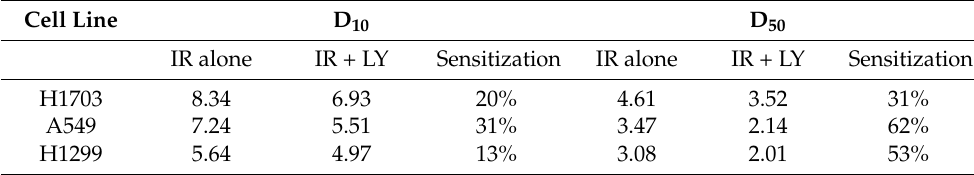
IR, X-rays; LY, LY2874455 (100